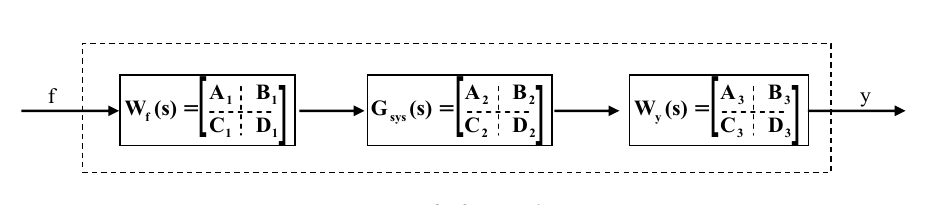
Fig. 4. Transfer function